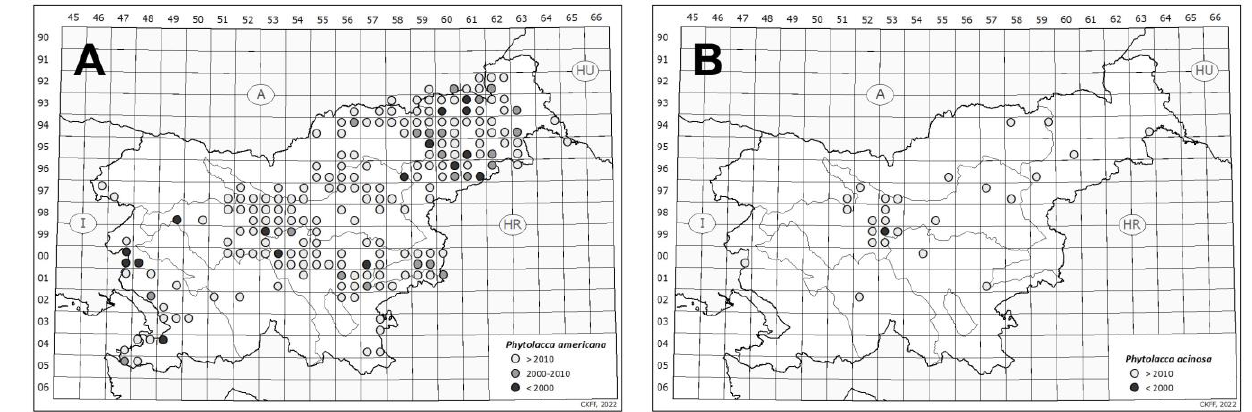
Figure 5. The MTB quadrants with data on P. americana ( A ) and P. acinosa ( B ) outside gardens in Slovenia. Black dots represent data up to 2000, grey dots from 2000 to 2010, and white dots from 2010 on.